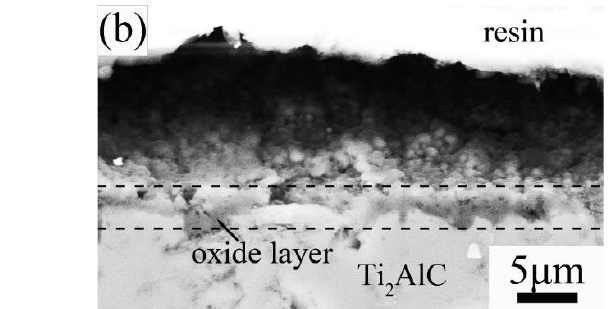
Figure 3. Scanning electron microscope (SEM) micrographs of sample surface of Ti 2 AlC ceramic quenched in air at different temperatures: ( a ) 920 °C and ( b ) 1150 °C.